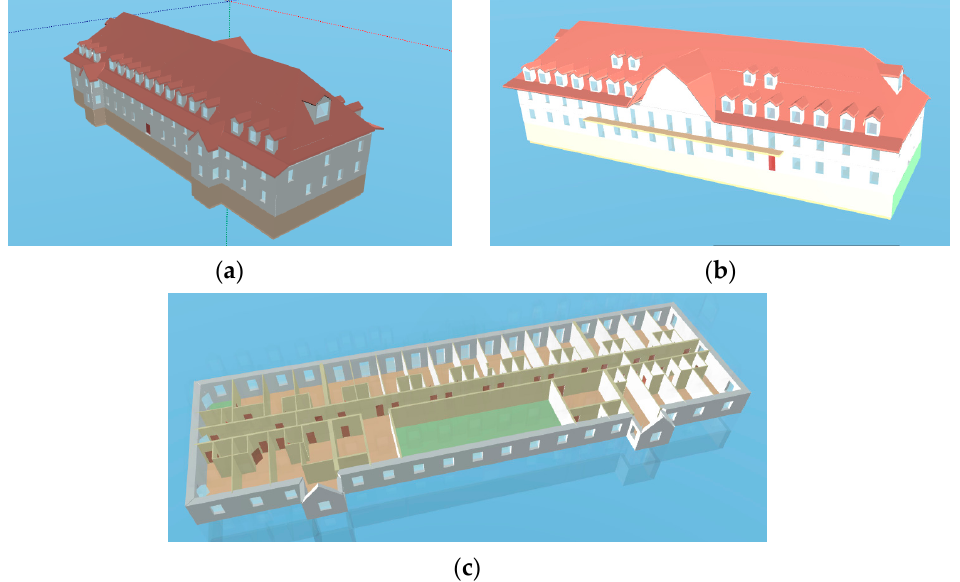
Figure 4. 3D model of the analyzed building: ( a ) northwest corner of the building; ( b ) southeast view; ( c ) floor view with particular rooms.